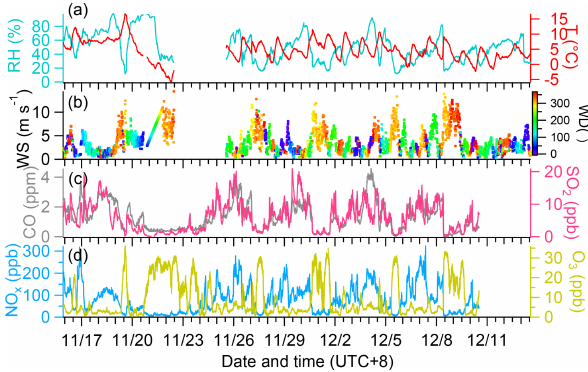
Figure 1. Temporal variation in (a) relative humidity (RH) and tem- perature ( T , ◦ C), (b) wind speed (WS, ms − 1 ) and wind direction (WD) and (c, d) mass loadings of CO, SO 2 , NO x and O 3